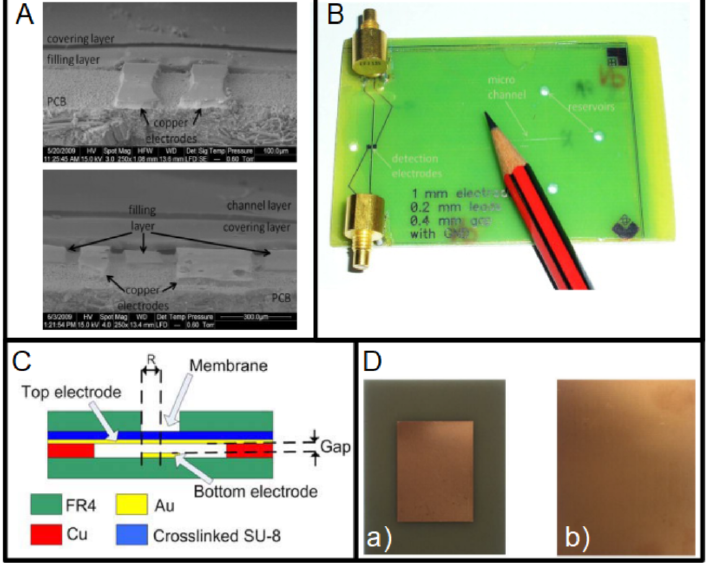
Figure 8. ( A ) Two layers of 30 µ m thick dry film photoresist (DFR) laminated on top of electrodes on a PCB (reprinted from [115], copyright (2011), with permission from Elsevier). ( B ) Device with the previously noted electrodes integrated on the PCB (reprinted from [115], copyright (2011), with permission from Elsevier). ( C ) Cross-section view of a pressure sensor with the gap defined using the thickness of the copper layer (copyright (2015) IEEE. Reprinted, with permission, from [104]). ( D ) Sensor fabricated: (a) radiation patch on the upper surface; and (b) metallic ground on the lower surface (reprinted from [111], copyright (2018), Creative Commons